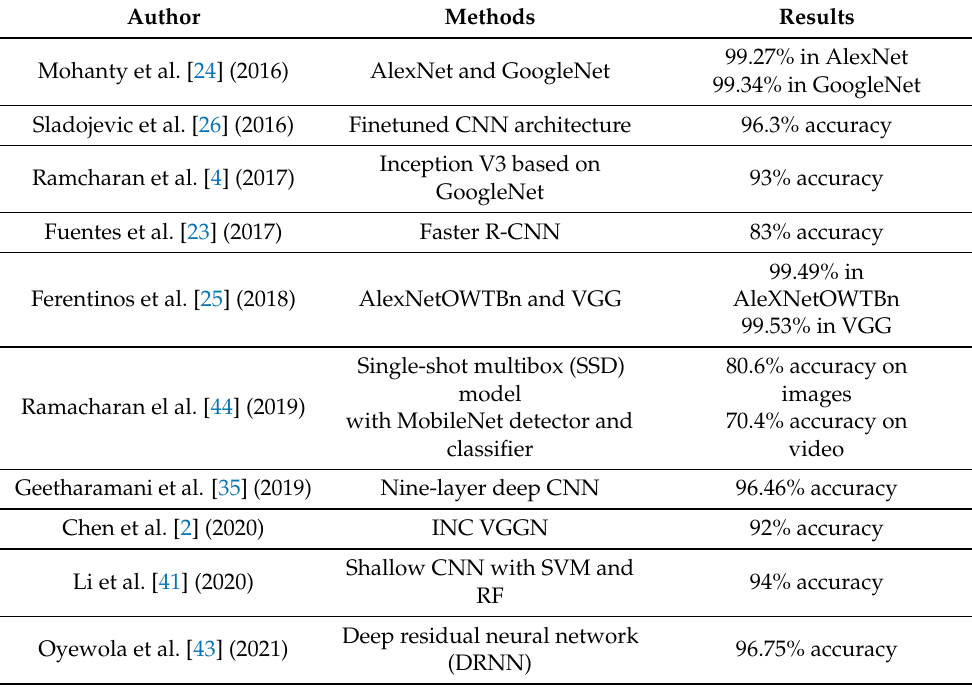
Table 1. Summary of related work on plant-disease